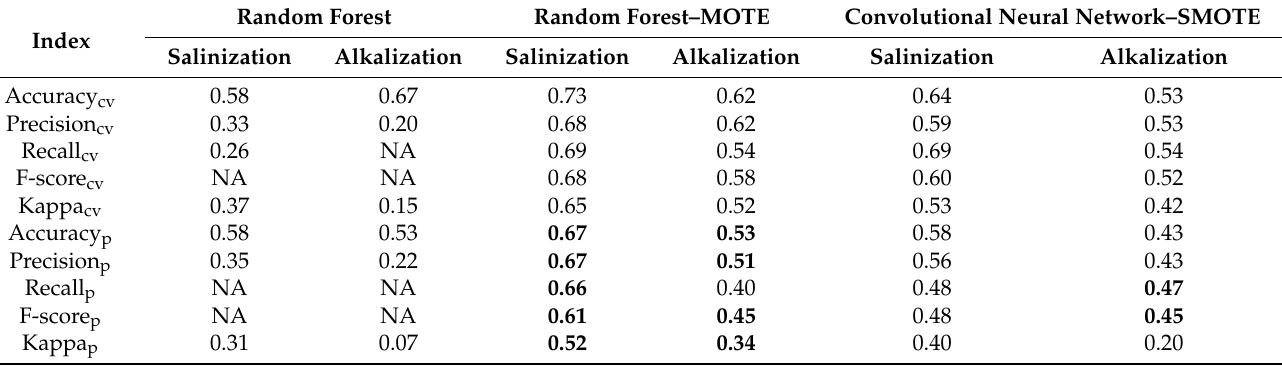
Table 6. The performance of random forest (RF) and convolutional neural network (CNN) in the training and test